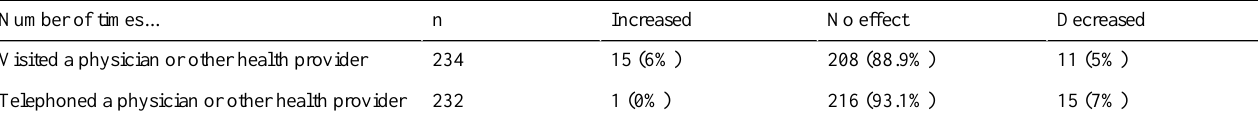
Table 7. Perceived effects of Internet use on health-related activities (number of times visited or telephoned a physician or other health provider) among Internet users